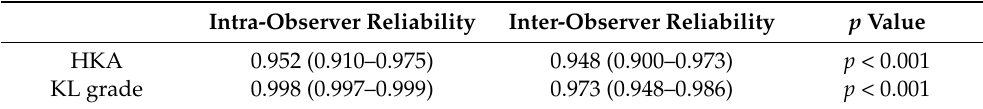
Table 1. Intra-observer and inter-observer reliability of radiographic